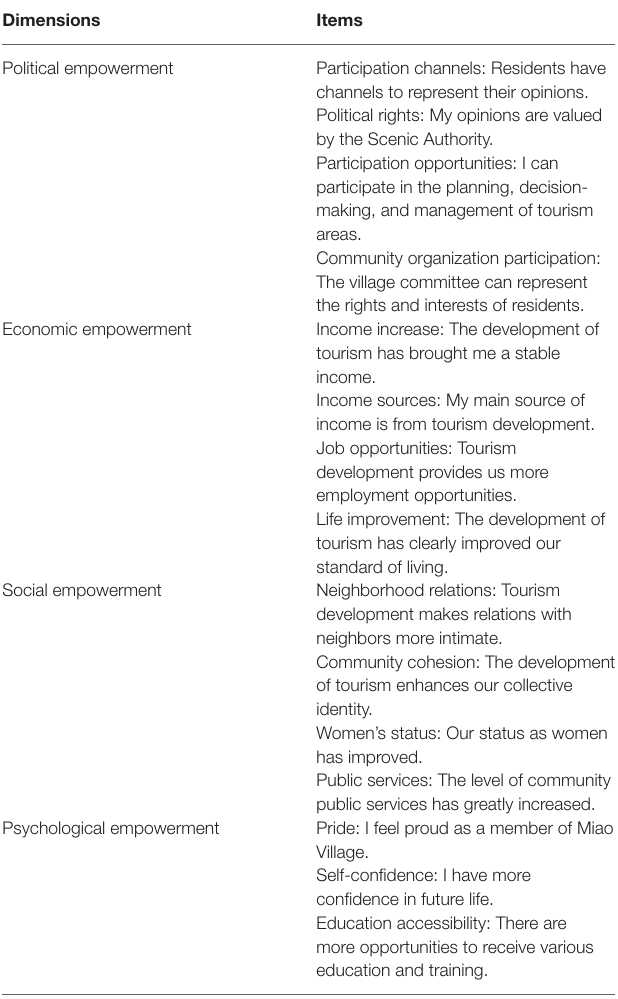
TABLE 4 | Measurement scale of community empowerment. Dimensions Items Political empowerment